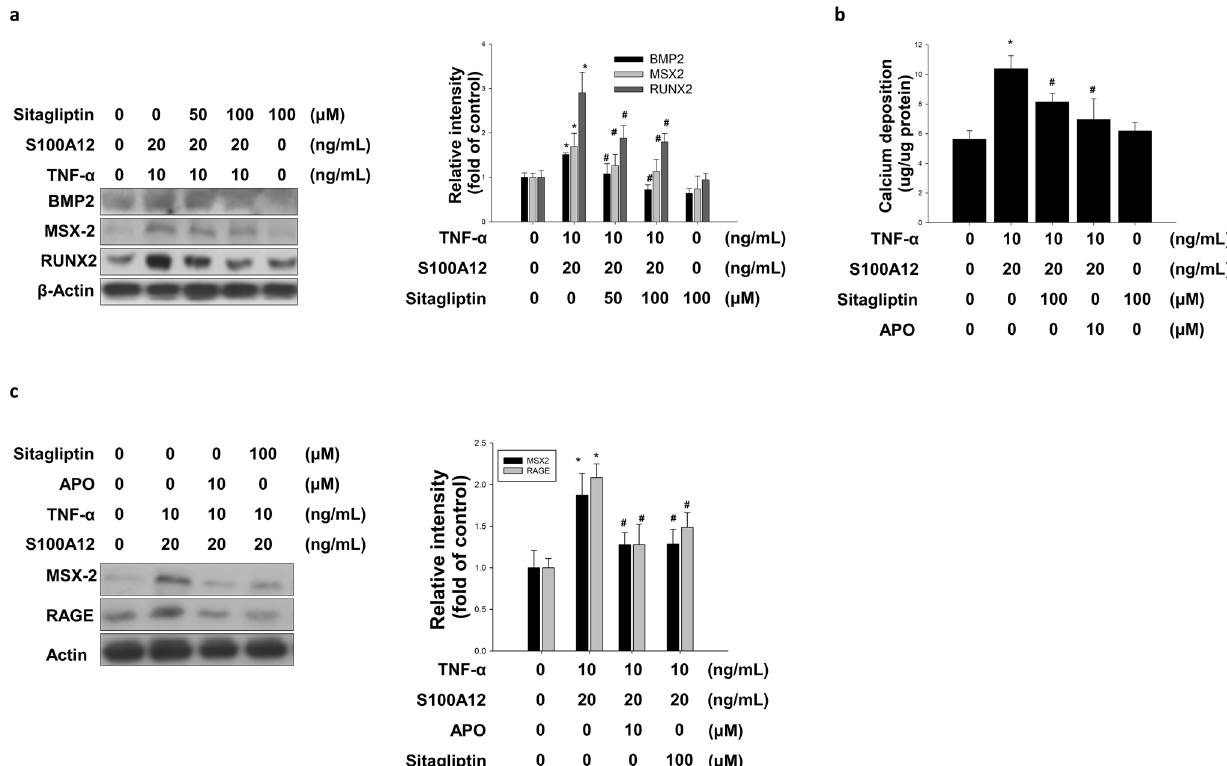
Figure 5. Sitagliptin modulated ROS generation and the expression of RAGE. (a) HASMCs were cultured in an osteogenic differentiation medium for 1 day in the presence or absence of TNF-α combined with S100A12 and concomitantly with sitagliptin. Sitagliptin blocked the induction of MSX2, BMP-2, and RUNX2 accumulation induced by TNF-α combined with S100A12. (b) Antioxidant agents (NAC and APO) attenuated the TNF-α combined with S100A12-induced bone marker MSX2 and (c) RAGE accumulation in HASMCs (sitagliptin; NAC: ROS scavenger; APO: Nox inhibitor). * P < 0.05 compared with the control group, and # P < 0.05 compared with the TNF-α combined with S100A12 groups. N = 6 for each set of